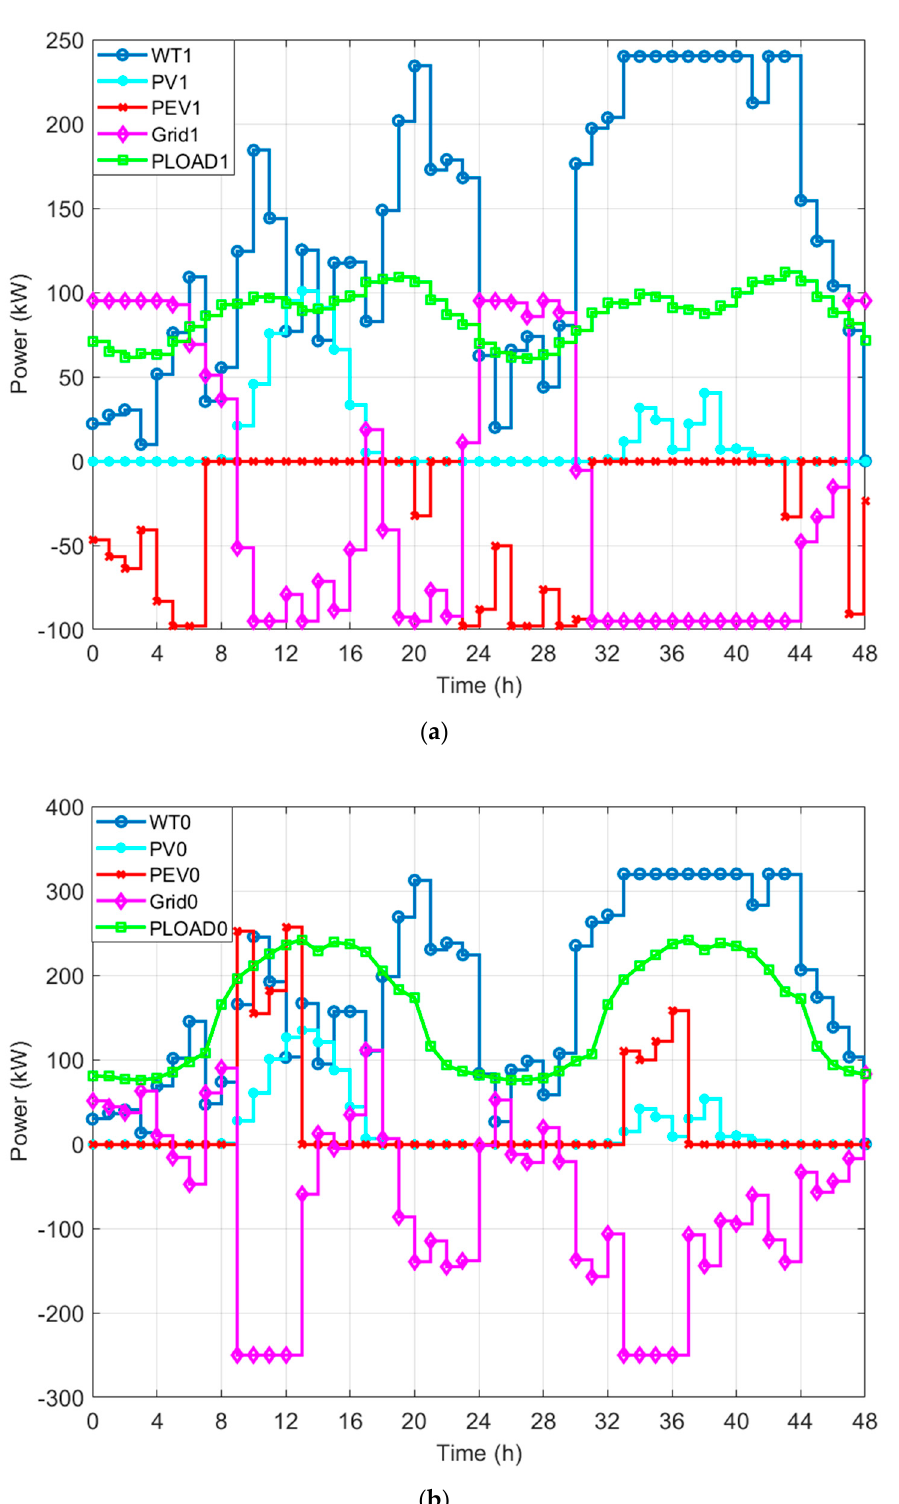
Figure 7. Dispatching results in Case 2: ( a ) Dispatching profiles of RMG1; ( b ) Dispatching profiles of OBMG.